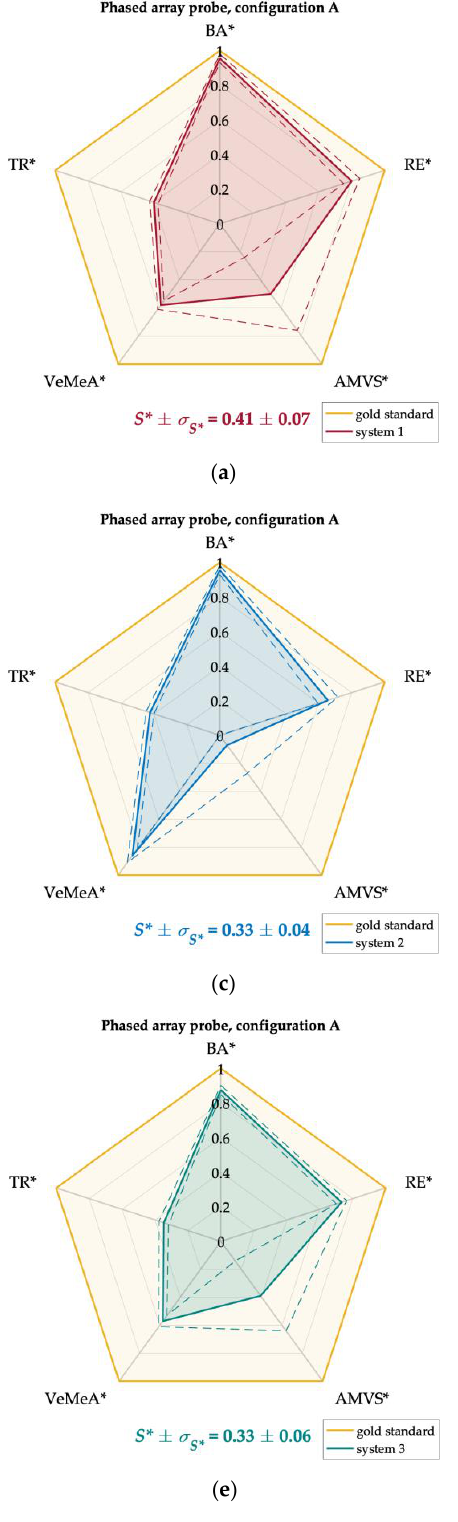
Figure 10. Kiviat diagrams for systems 1 ( a , b ), 2 ( c , d ) and 3 ( e , f ) equipped with phased array probes in configurations A ( a , c , e ) and B ( b , d , f ), for high flow rate regime Q H . Each polygon area was normalized with respect to the gold standard one.